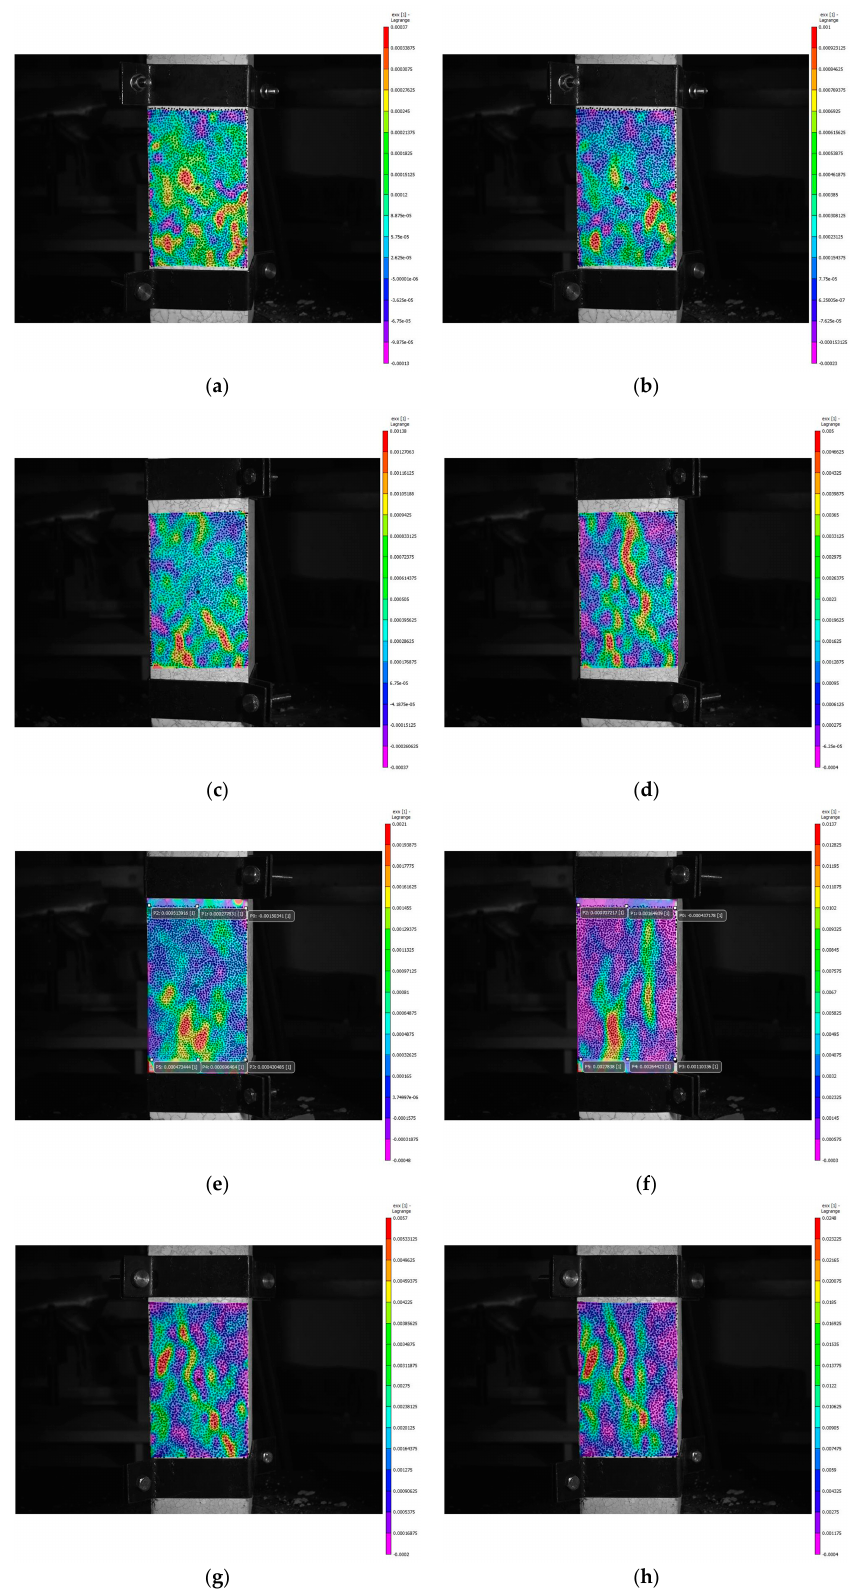
Figure 8. Strain nephogram of SAC: ( a ) 200 °C 80% peak strain; ( b ) 200 °C peak strain; ( c ) 400 °C 80% peak strain; ( d ) 400 °C peak strain; ( e ) 600 °C 80% peak strain; ( f ) 600 °C peak strain; ( g ) 800 °C 80% peak strain; ( h ) 800 °C peak strain.